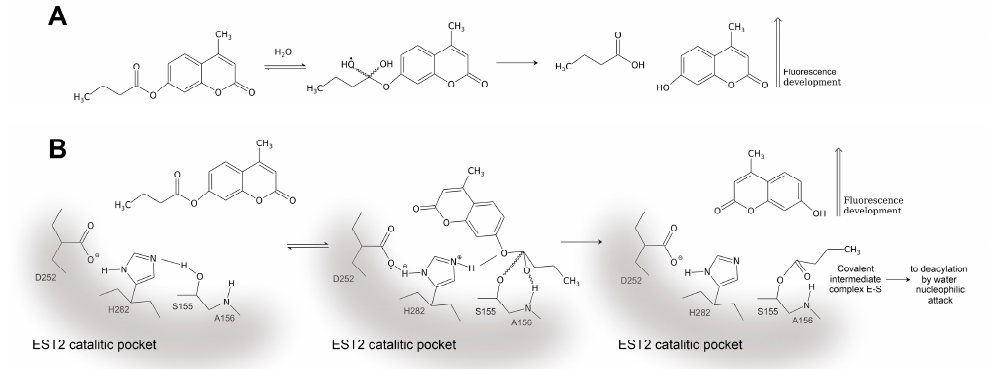
Scheme 1. Mechanism of ( A ) the spontaneous hydrolysis of 4-methylumbelliferyl butyrate (4-MUBu), in 2-[4-(2 Hydroxyethyl)-1-piperazino]-ethansulfonic acid (HEPES) bu ff er and ( B ) by enzymatic hydrolysis after the addition of esterase-2 (EST2). The release of 4-methylumbelliferone (4-MU) produces the increase in